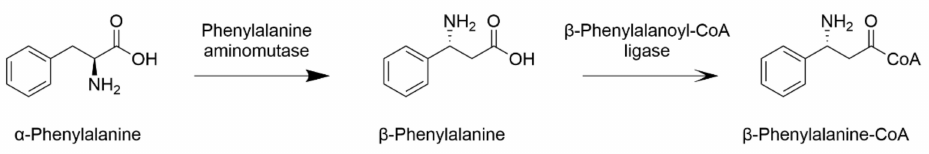
Figure 6. Simplified phenylpropanoid pathway of baccatin III